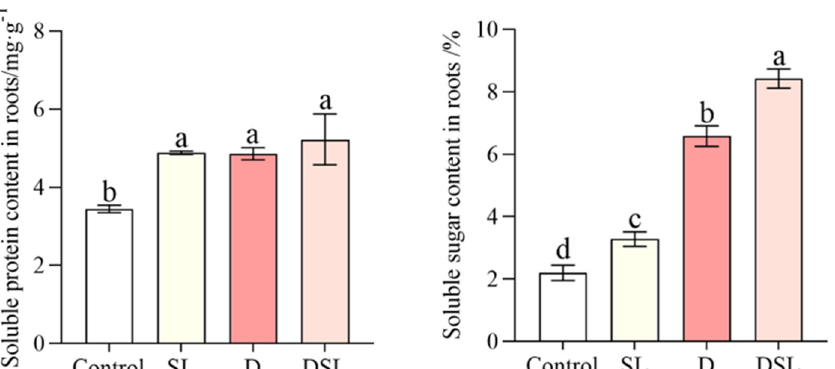
Figure 3. Soluble sugar and soluble protein contents of alfalfa root in response to different treatments. Results are presented as the mean of four independent experiments ± standard error. a–d Different superscripts mark significant differences between the treatments ( p < 0.05).